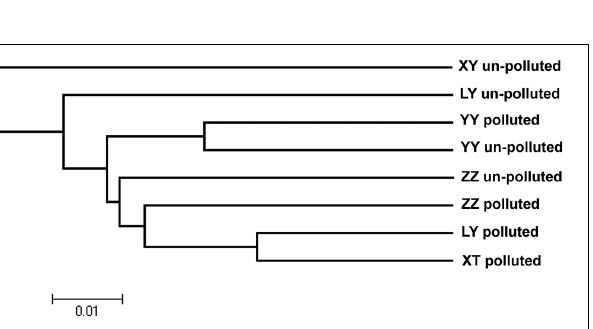
FIGURE 4 | Discriminant analysis of variations in phenotypic traits of 40 bermudagrass accessions under cadmium stress. LY, ZZ, XT, and YY mean Liuyang, Zhuzhou, Xiangtan, and Yueyang City, respectively.